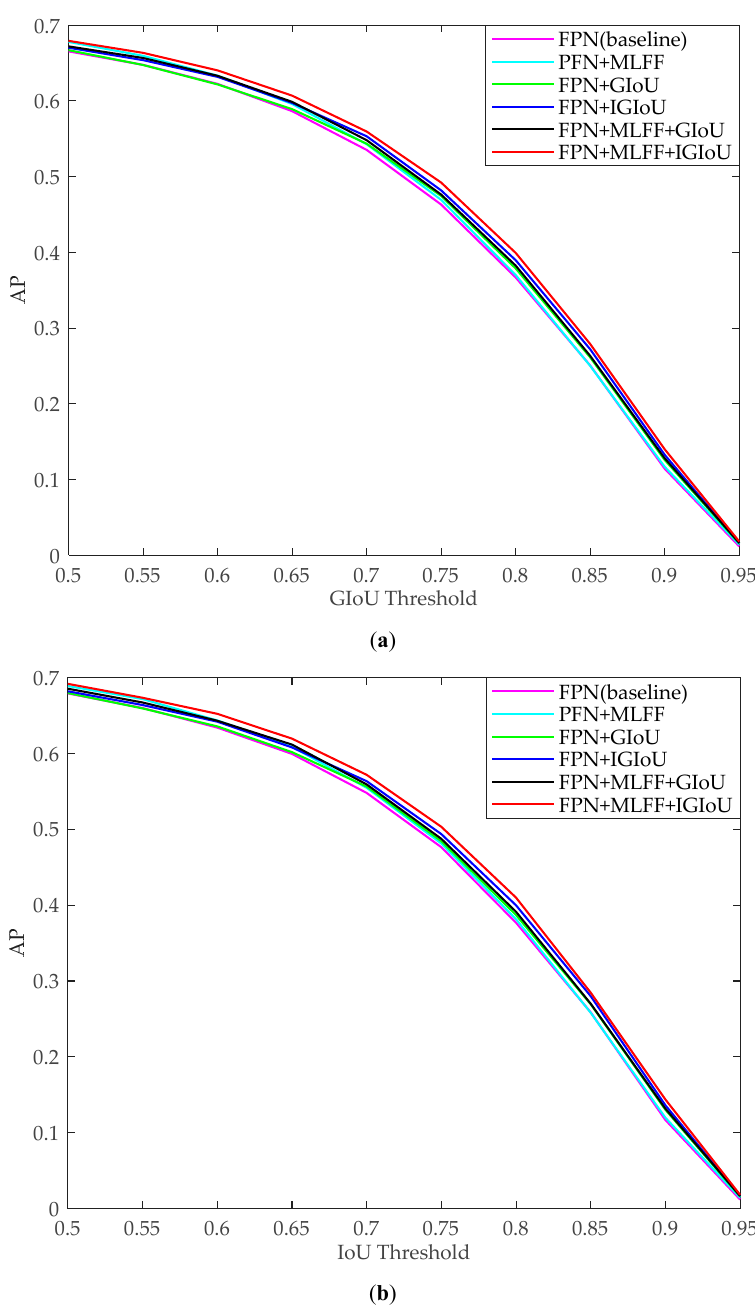
Figure 8. Comparison with baseline methods on the DIOR dataset in terms of curves of AP with different GIoU (IoU) thresholds. ( a ) GIoU threshold; ( b ) IoU threshold.